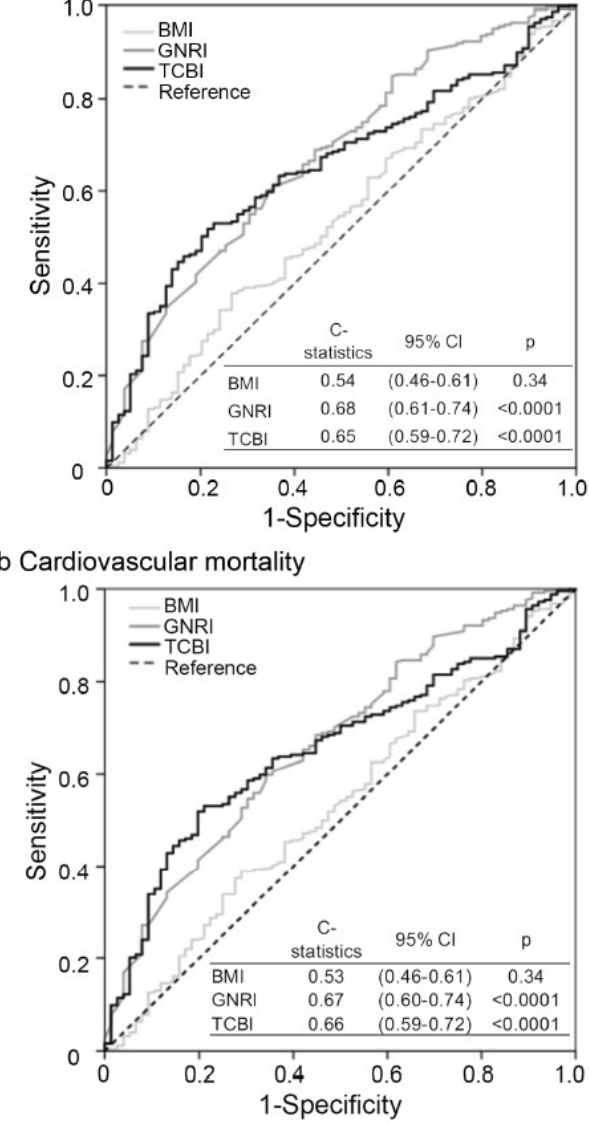
Figure 4. Prognostic implication of BMI, GNRI, and TCBI for all-cause and cardiovascular mortalities. Receiver operating characteristic (ROC) curves of BMI, GNRI, and TCBI with reference line for all-cause (a) and cardiovascular (b) mortality.